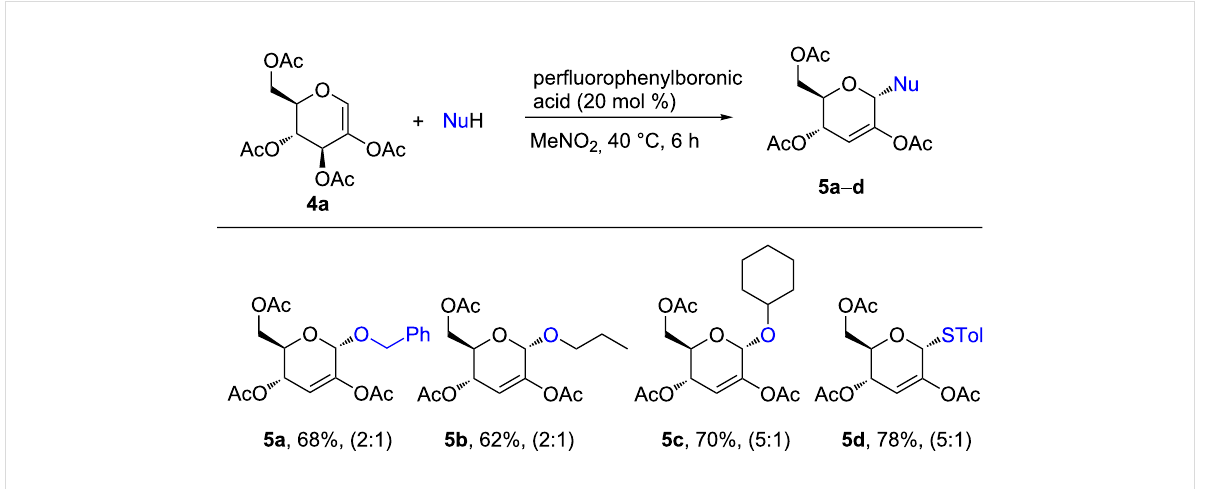
Figure 2: Perfluorophenylboronic acid-catalyzed reaction between 2,3,4,6-tetra- O -acetyl-D-glucal 4a and O- and S -nucleophiles.